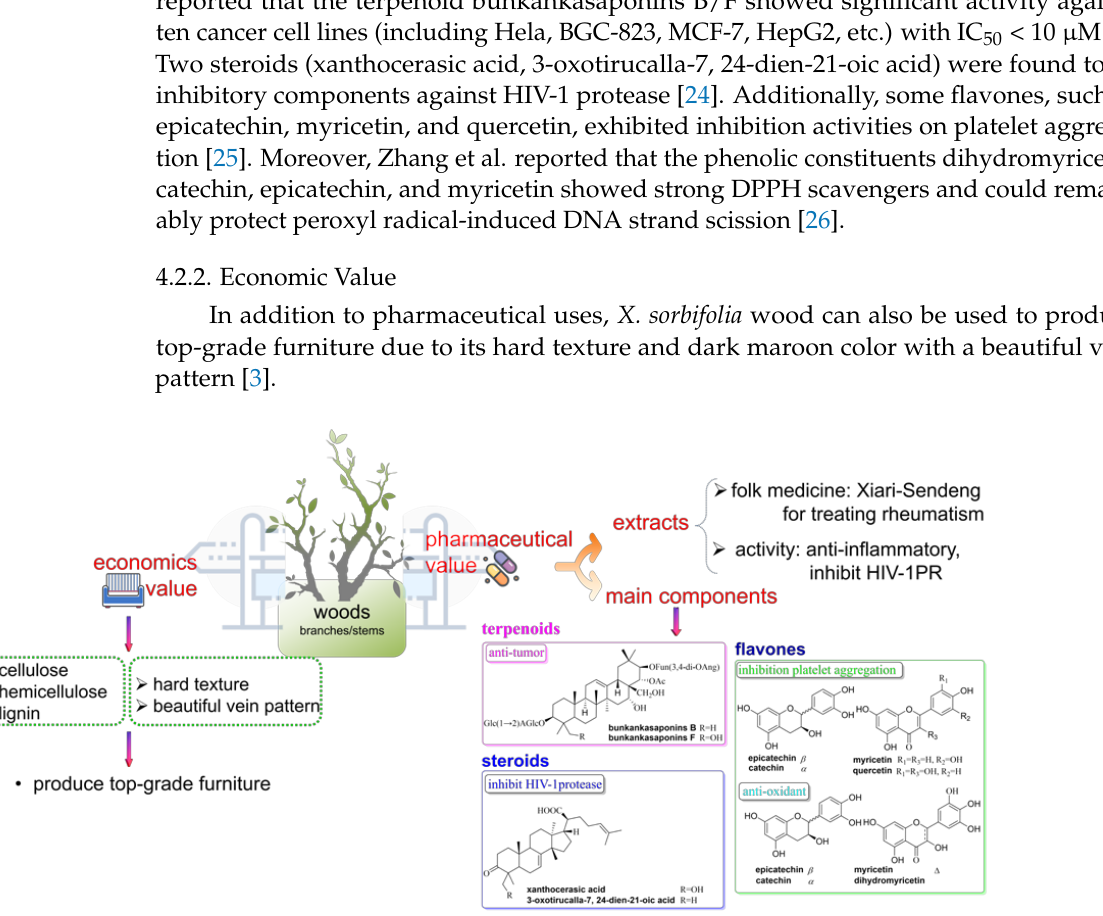
Figure 2. The uses of wood/branches/stems of X.